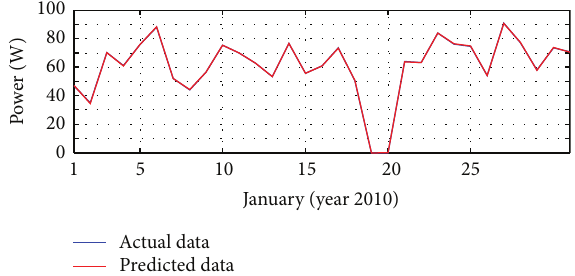
Figure 5: Results for real data and FFBP for January 2010.